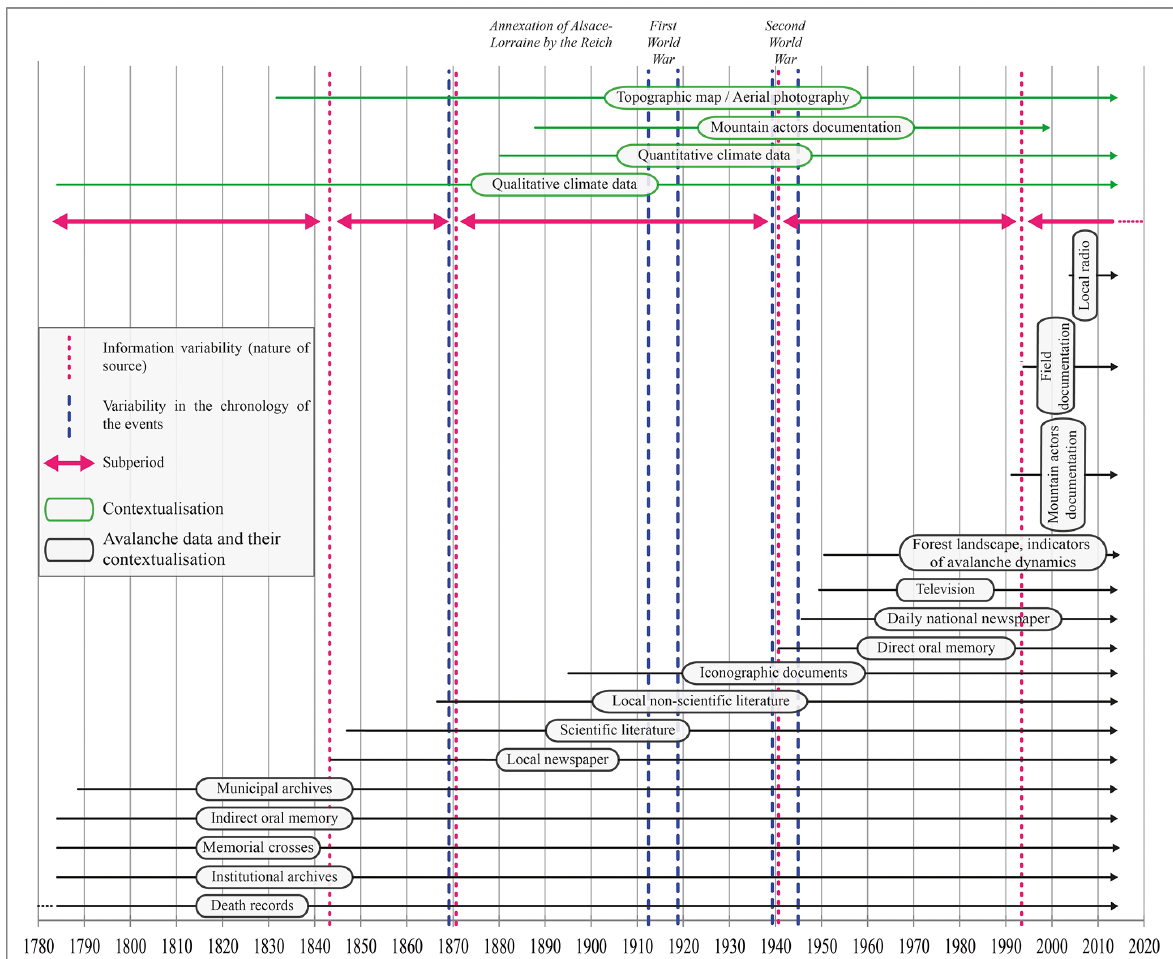
Figure 5. (Re)source availability as a function of time. Subperiods are delimited according to the predominance of a given type of source. “Contextualisation sources” refers to sources that were used to describe the historical, geographical and societal context only, whereas “avalanche data and their contextualisation sources” refers to sources that were used to both build the avalanche geo-chronology and under- stand the context of the corresponding